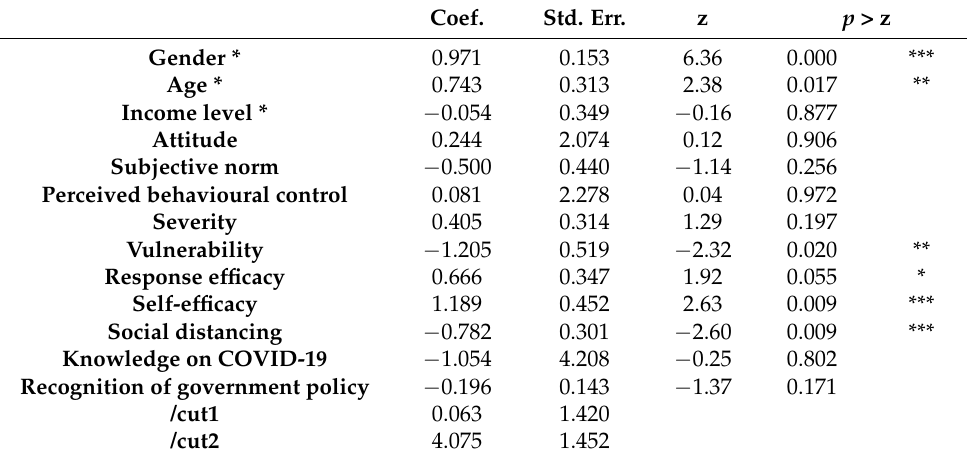
Table 4. Result of analysis by ordered logit model of determinants leading to selection of offline shopping channels during COVID-19 crisis. Coef. Std. Err. z p > z Gender * 0.971 0.153